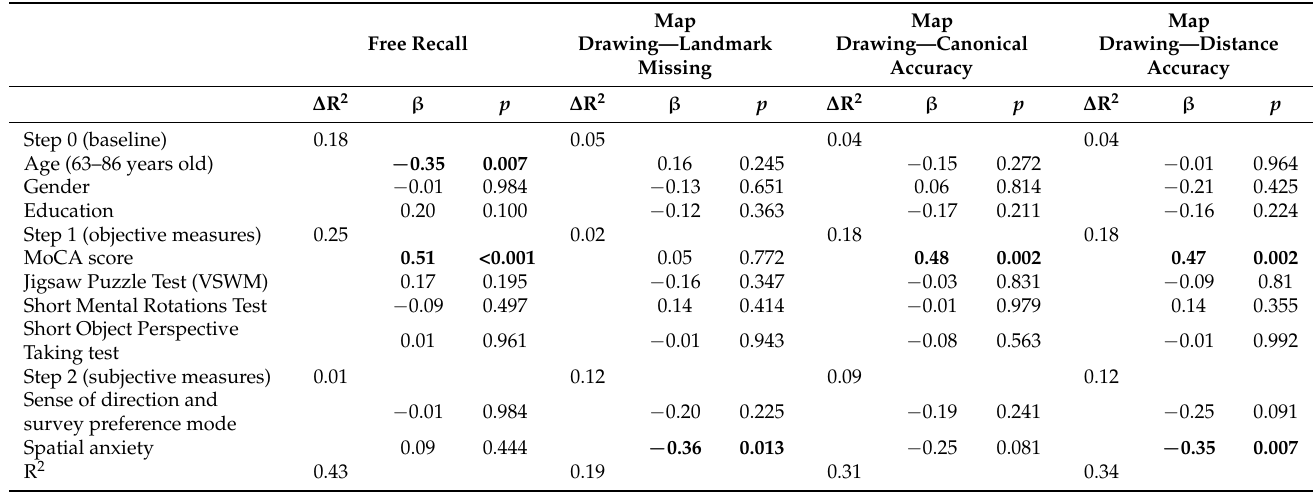
Table 2. Regression models for free recall and map drawing index accuracy in older adults.